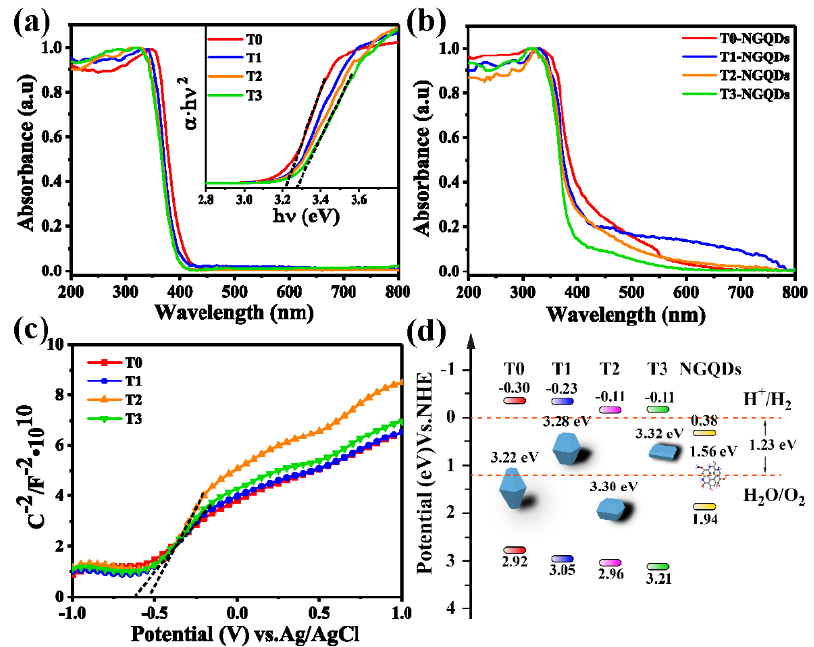
Figure 4. UV-vis diffuse reflection spectra (UV-DRS) of ( a ) bare anatase TiO 2 , ( b ) TiO 2 /NGQDs composites, ( c ) Mott–Schottky plots of bare anatase TiO 2 , and ( d ) band structure diagram of different samples and NGQDs. The inset in ( a ) is the Tauc plot of the corresponding bare anatase TiO 2 .